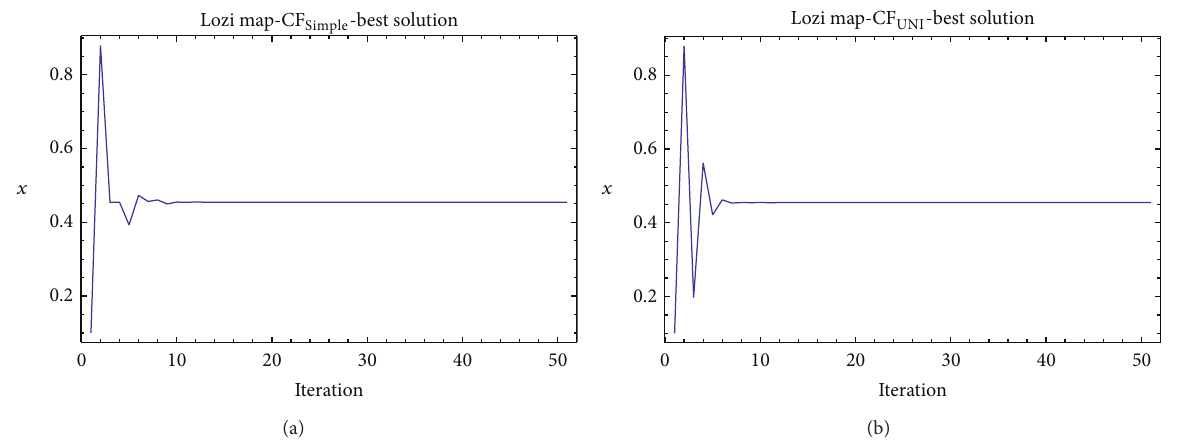
Figure 15: Simulation of the best individual solution, ChaosDE and Lozi map: case study 5, CF Simple (a); case study 6, CF